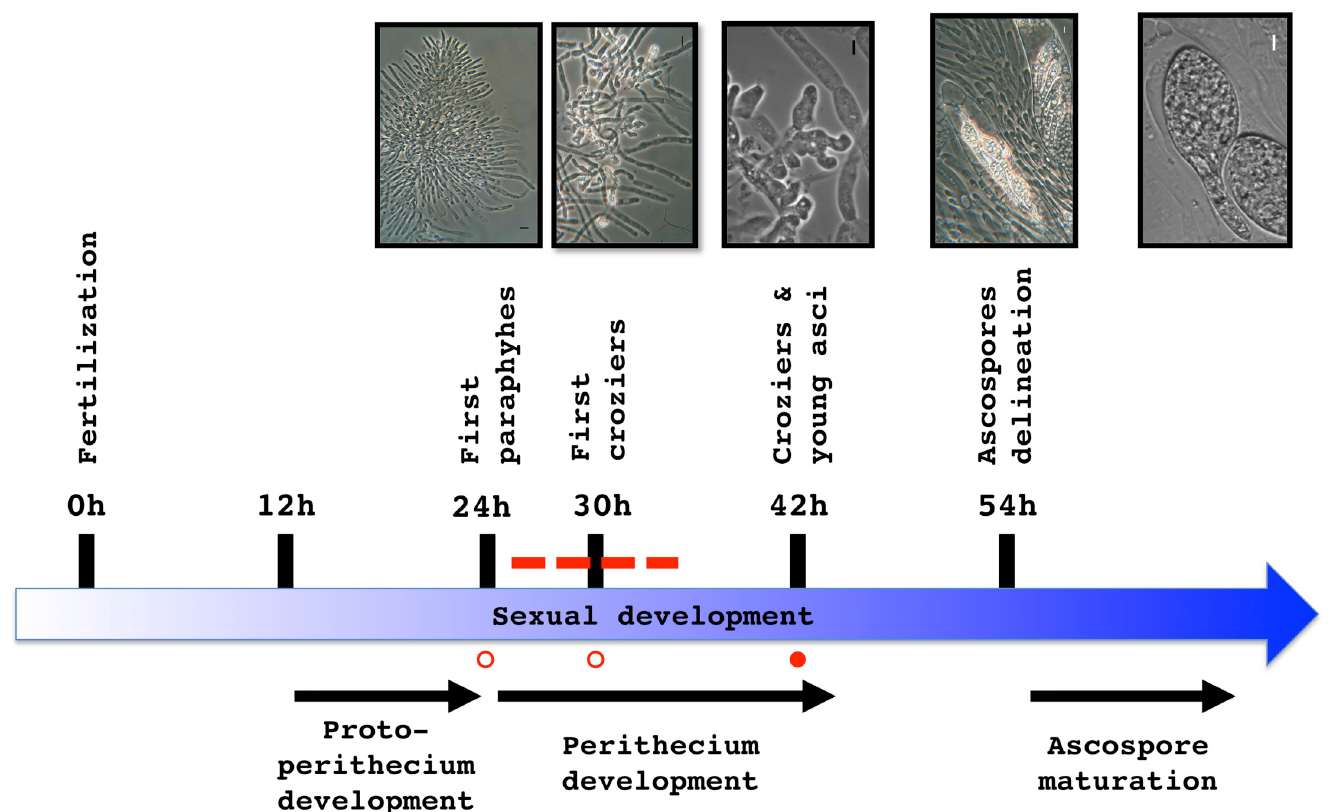
Fig 6. Transcriptomic analysis experimental design. Schematic developmental time course from fertilization to ascospore maturation of wild-type crosses. Total RNA was extracted from wild-type perithecia at T24 and T30 (open circles) and from Δ PaRid micro-perithecia at T42 (solid circle); Dotted line: time frame during which the Δ PaRid developmental blockage might occur. Light microphotographs of the upper panel illustrate the various developmental steps indicated along the time